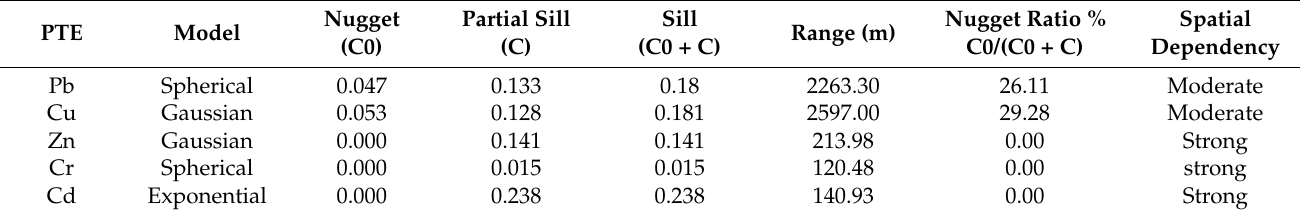
Table 5. Theoretical fitting semivariograms models and spatial